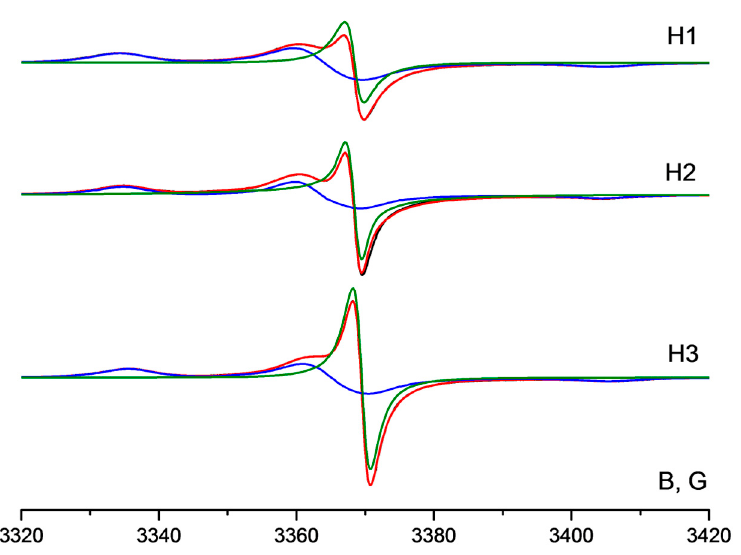
Figure 4. EPR spectra of H1, H2, and H3 in powder graphite oxide samples at 120 K. Black lines—experimental spectra, red lines—simulation results, blue lines—signals of nitroxide radicals, green lines—native signals of graphite